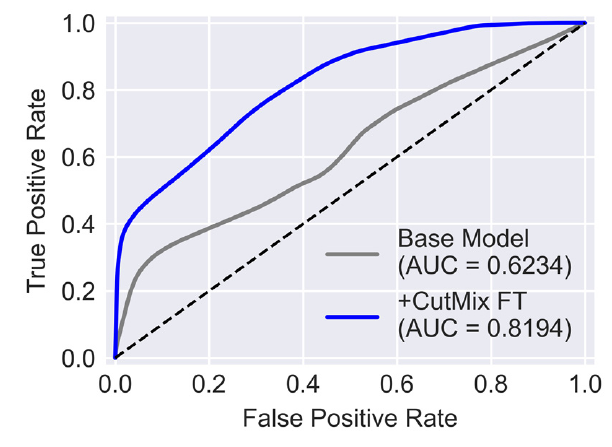
Figure 13. Comparison of ROC curves of models evaluated with target dataset.